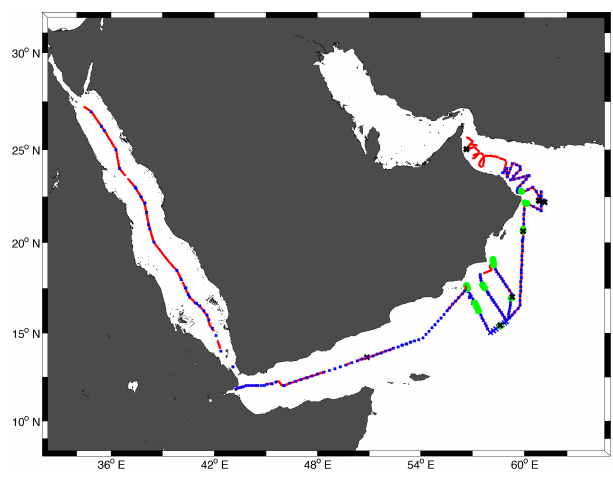
Figure 2. Location of the Phys-Indien 2011 measurements. The red line follows the VM-ADCP and SeaSoar lines (with the exception of the Red Sea and Gulf of Aden, where only the VM-ADCP was acti- vated). The blue crosses and green circles represent the positions of XBT-XCTD casts and of CTD-LADCP stations, respectively. The black crosses represent the launch positions of floats (Surdrift and